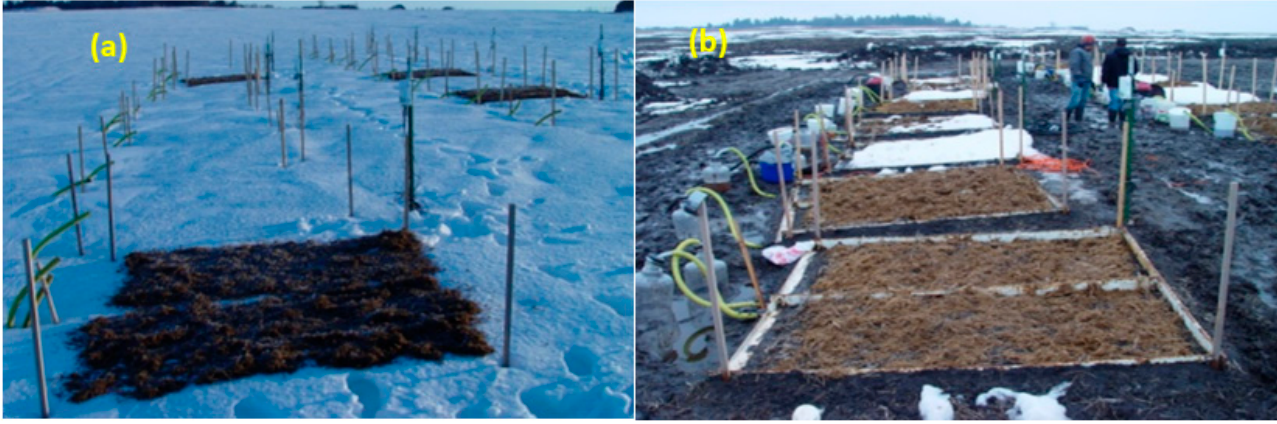
Figure 2. ( a ) Manure application in January 2010 (on top of snow); ( b ) snowmelt runoff collection in March